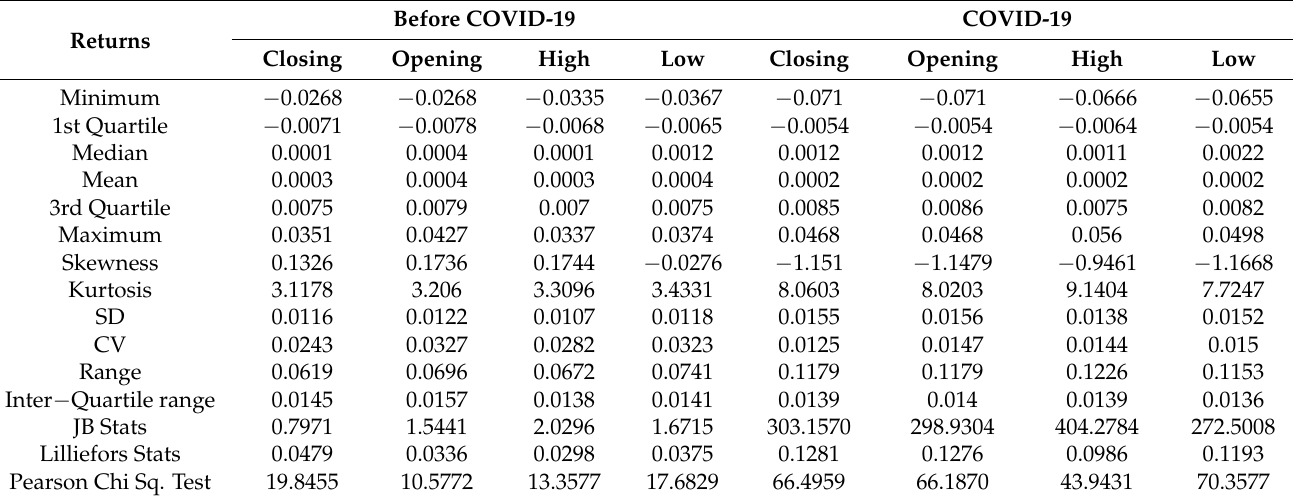
Table 1. Descriptive Statistics of PSX-100 for two periods: Before COVID-19 and COVID-19 pandemic.